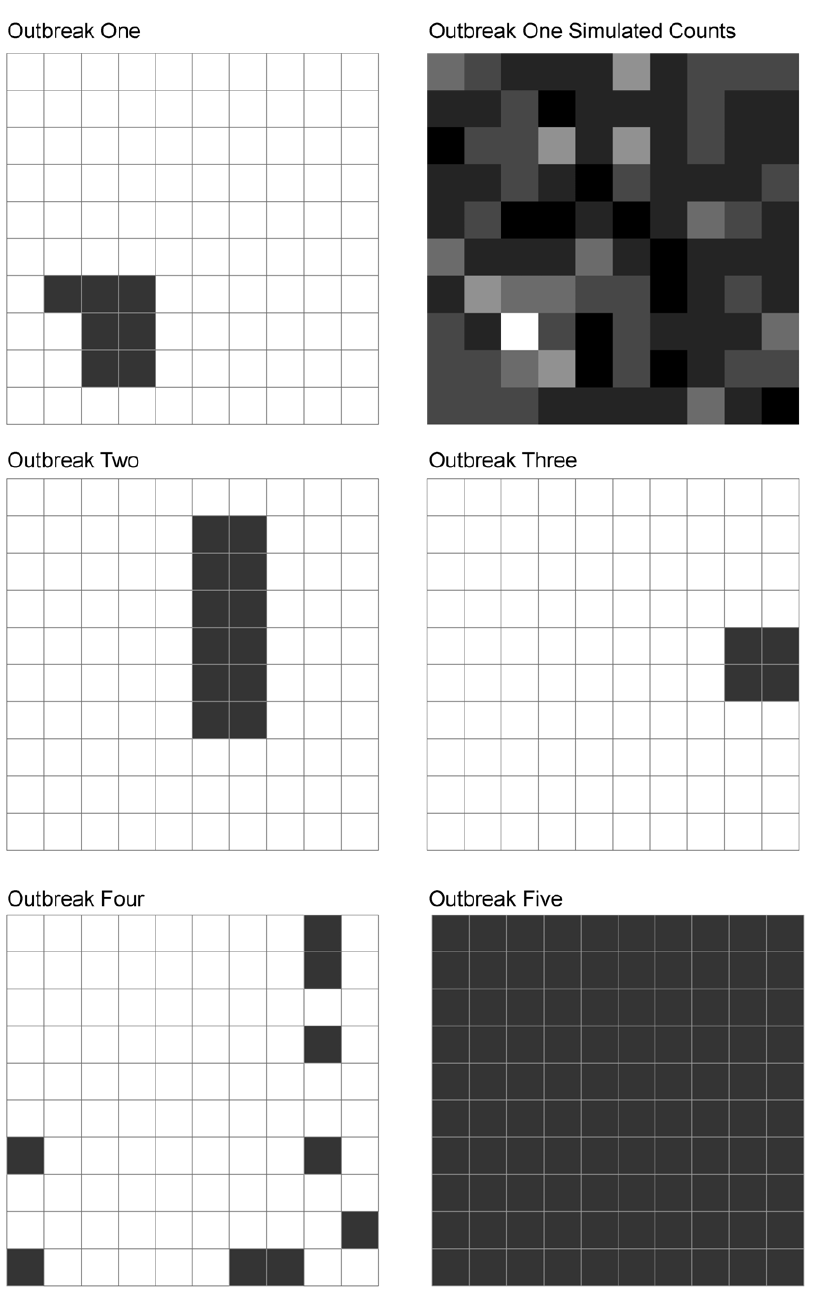
Figure 3. Simulated outbreak patterns in a hypothetical surveillance system. White cells generated under model for state one, and black cells generated under model for state two. The count data that was simulated using outbreak one is also shown: dark colours indicate low counts and lighter colours indicate high counts.